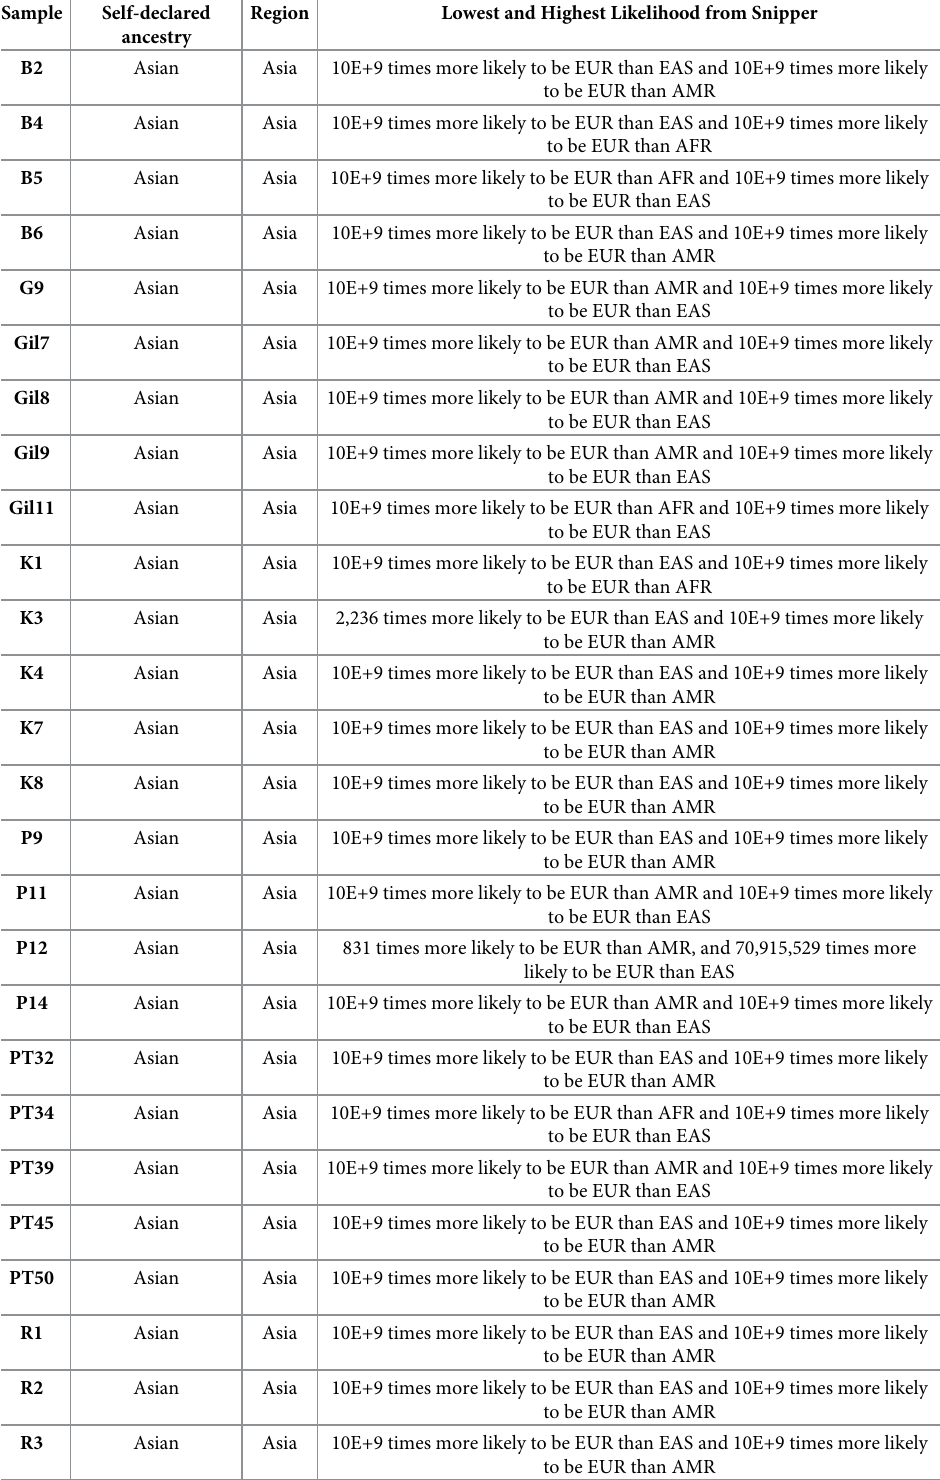
Table 6. Inferred biogeographic ancestry using snipper for male and female samples under